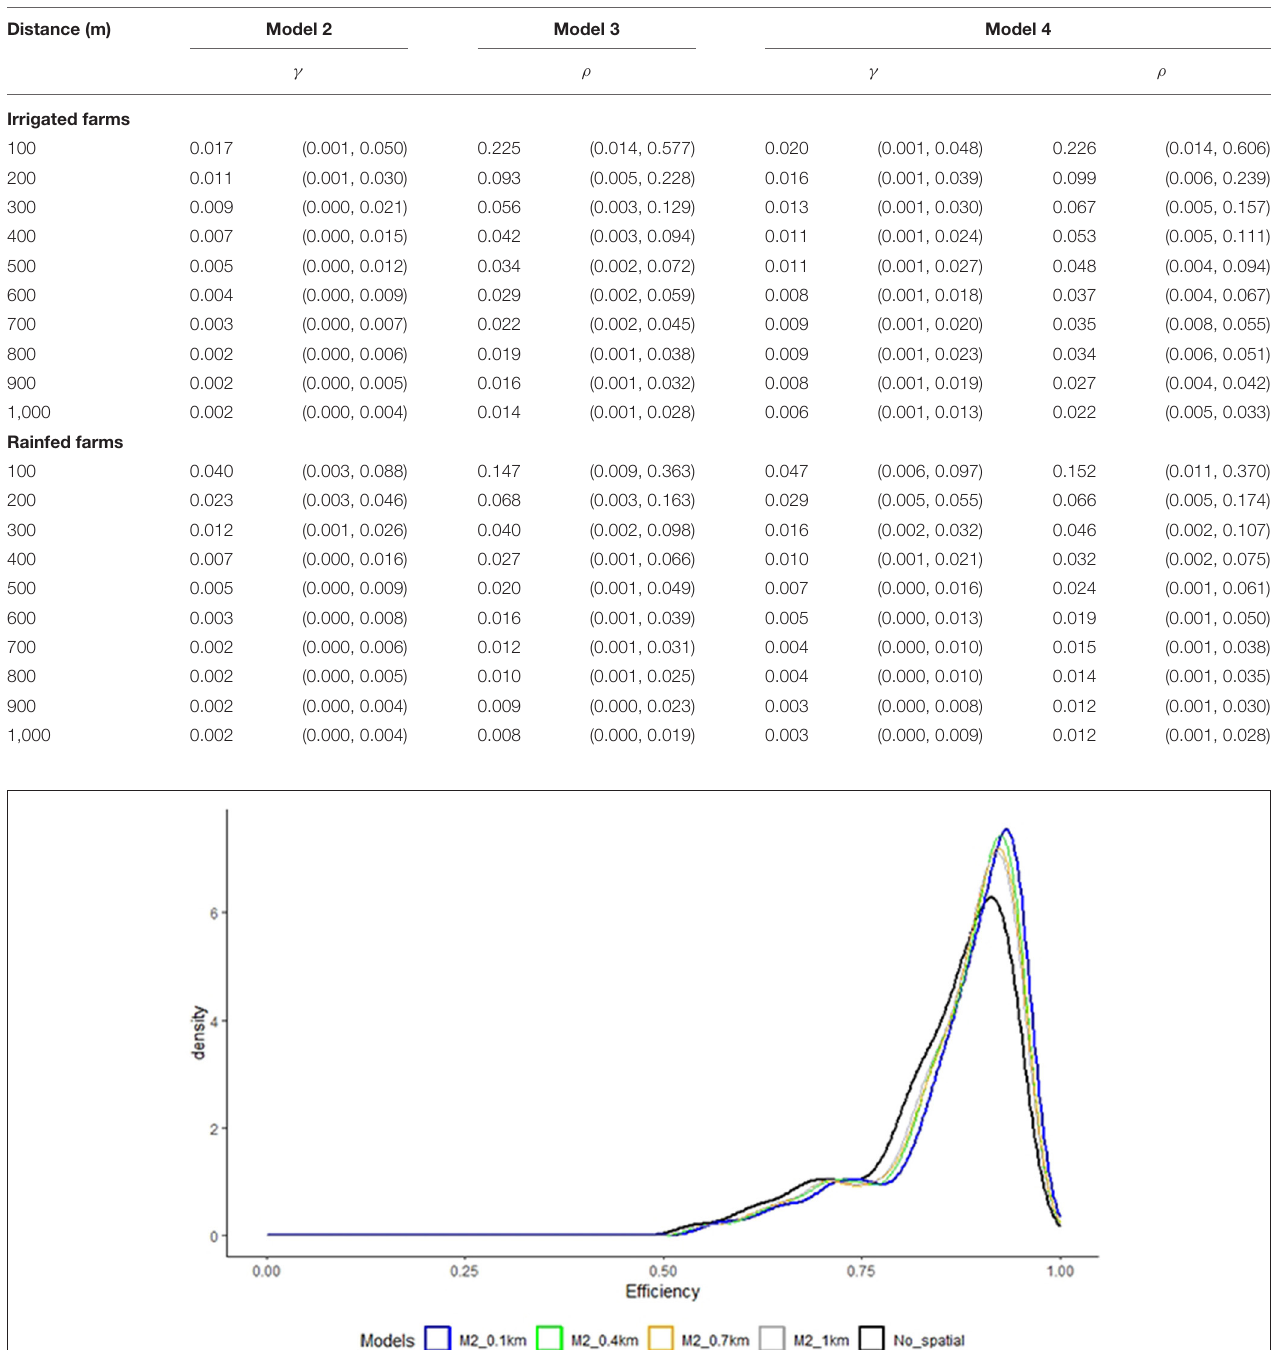
TABLE 1 | Spatial dependence parameters at different cut-off distances for models 2, 3, and 4 in irrigated farms and rainfed farms. Distance (m)